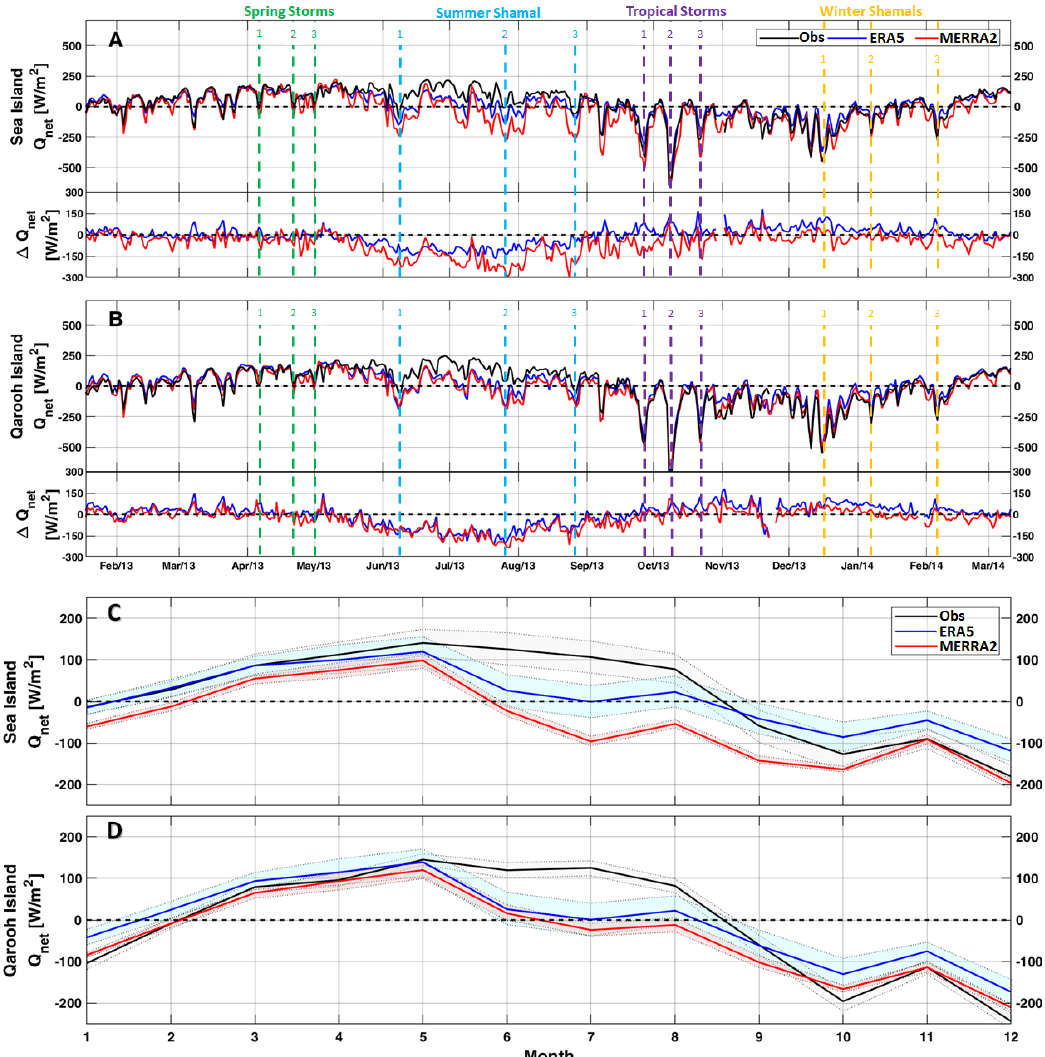
Figure 2. Time-averaged net heat fluxes obtained using the reanalysis products and observational data. Blue lines: ECWMF-ERA5 reanalysis data; red lines: NASA-MERRA2 reanalysis data; black lines: observations. ( A ) Daily heat fluxes at Sea Island station. ( B ) Daily heat fluxes at Qarooh Island station. ( C ) Monthly heat fluxes at Sea Island station and their 95% bootstrap confidence interval shaded. ( D ) Monthly heat fluxes at Qarooh Island station. Vertical dashed lines indicate spring wind events (green), summer Shamals (blue), tropical storms (magenta), and winter Shamals (orange). Positive values indicate net heat gain. ∆ Q net ( A , B ) represents the difference between reanalysis products and